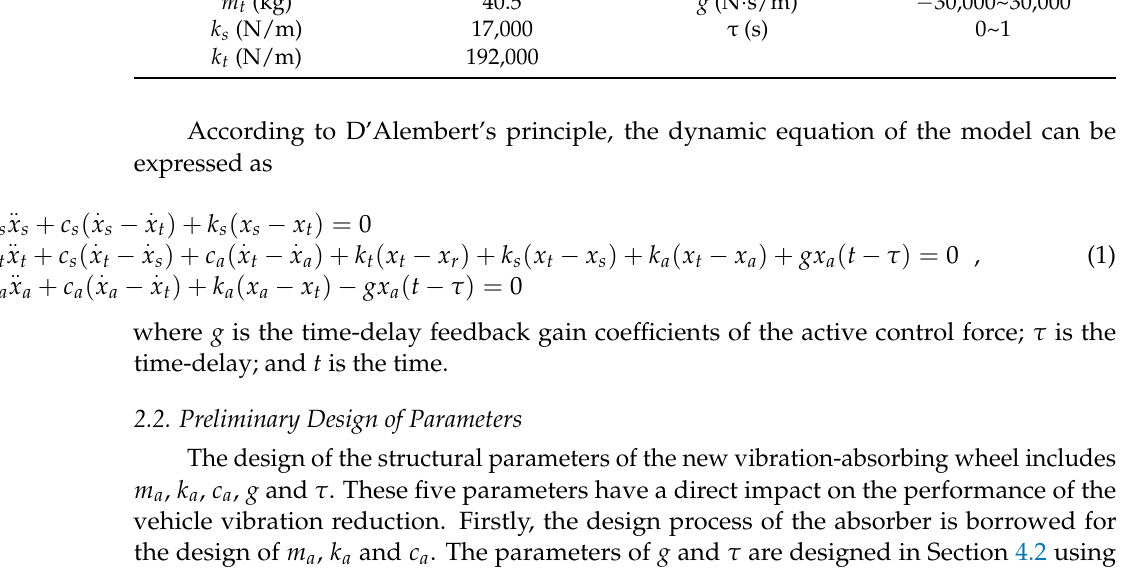
Table 1. Vehicle system model parameters.